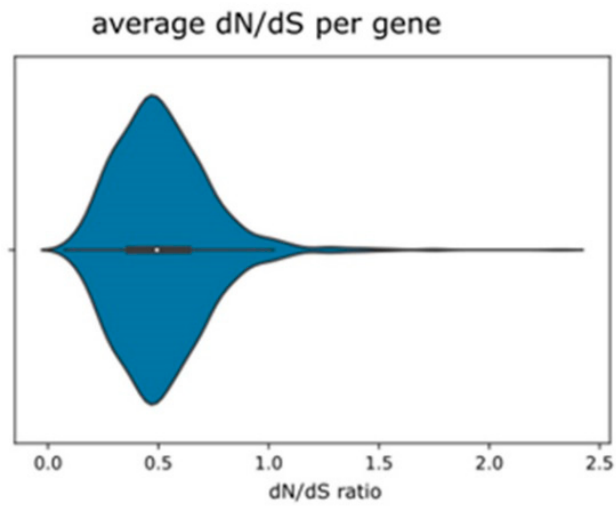
Figure 2. Violin plot depicting average dN/dS ratios across putative single-copy loci over all samples as inferred by Nej–Gojobori algorithm using Bioperl.